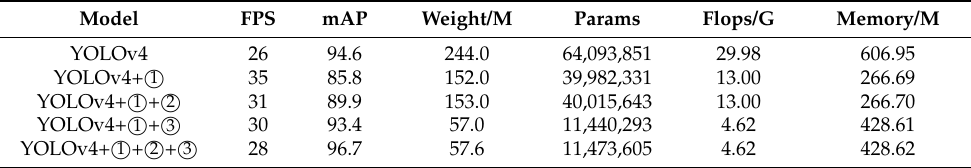
Table 1. Face-detection results of goats with different models under IOU =